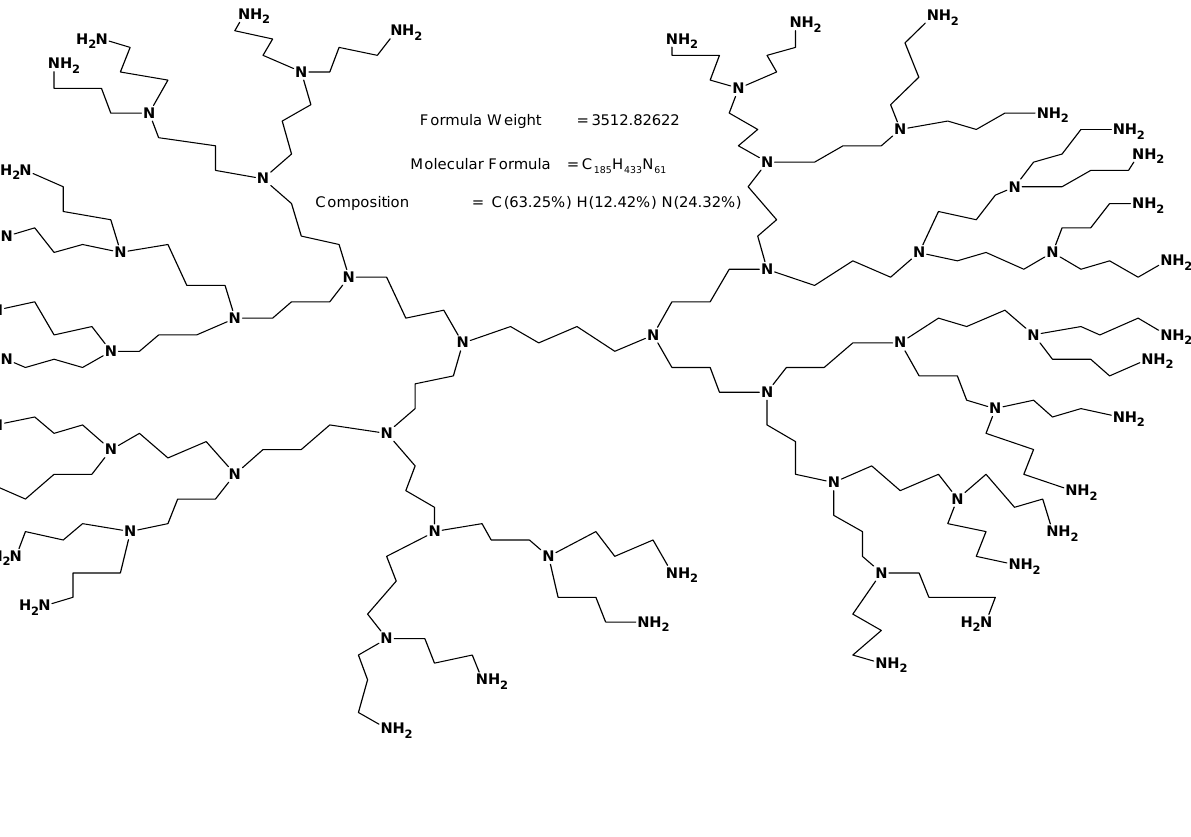
Figure 2. Structure of G4 Poly(propylene imine) dendrimer showing the peripheral primary amine and internal tertiary